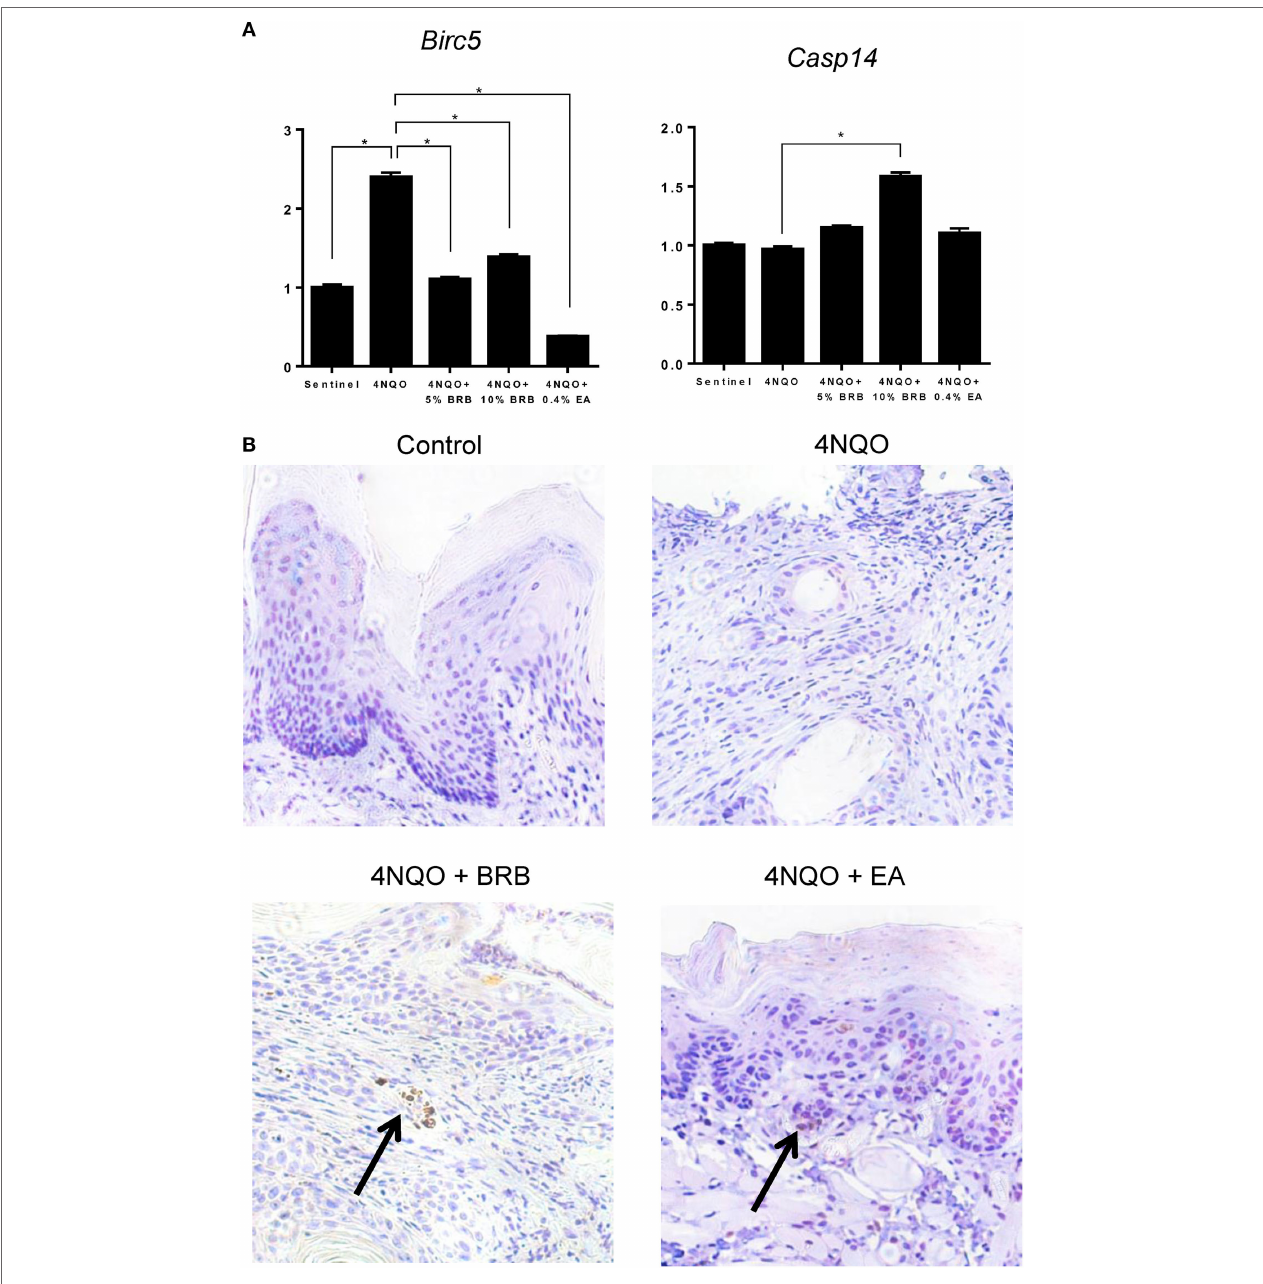
FigUre 6 | (a) Gene expression profiles of the apoptotic biomarkers Birc5 and Casp14 during 4-nitroquinoline 1-oxide (4NQO)-induced oral carcinogenesis as determined by reverse transcription quantitative PCR. Data are presented as mean fold induction over sentinels ± SE. * p -value < 0.05 for each group ( N ≥ 20) comparison using analysis of variance analysis. (B) Representative immunohistochemistry stained microscopic images ( × 100) of tongue tissues from sentinel rats and 4NQO exposed rats fed control diet, black raspberry (BRB) supplemented diet, or ellagic acid (EA) supplemented diet. Paraffin sections were stained with antibodies against cleaved caspase 3 and counterstained with hematoxylin. In 4NQO-exposed sections, regions of dysplasia or squamous cell carcinomas are shown. Arrow points to positively stained (apoptotic)